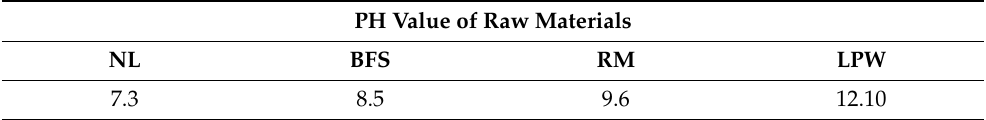
Table 5. pH values of raw